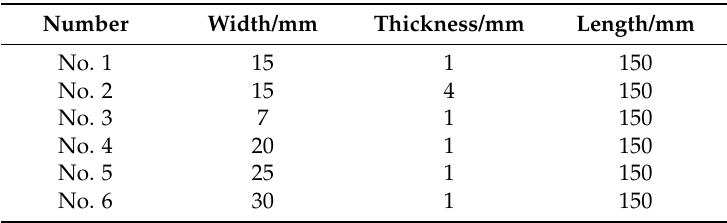
Figure 6. Room temperature experimental system: ( a ) Experimental set-up; ( b ) System sketch map. Table 3. The geometrical sizes of waveguide bars for test.